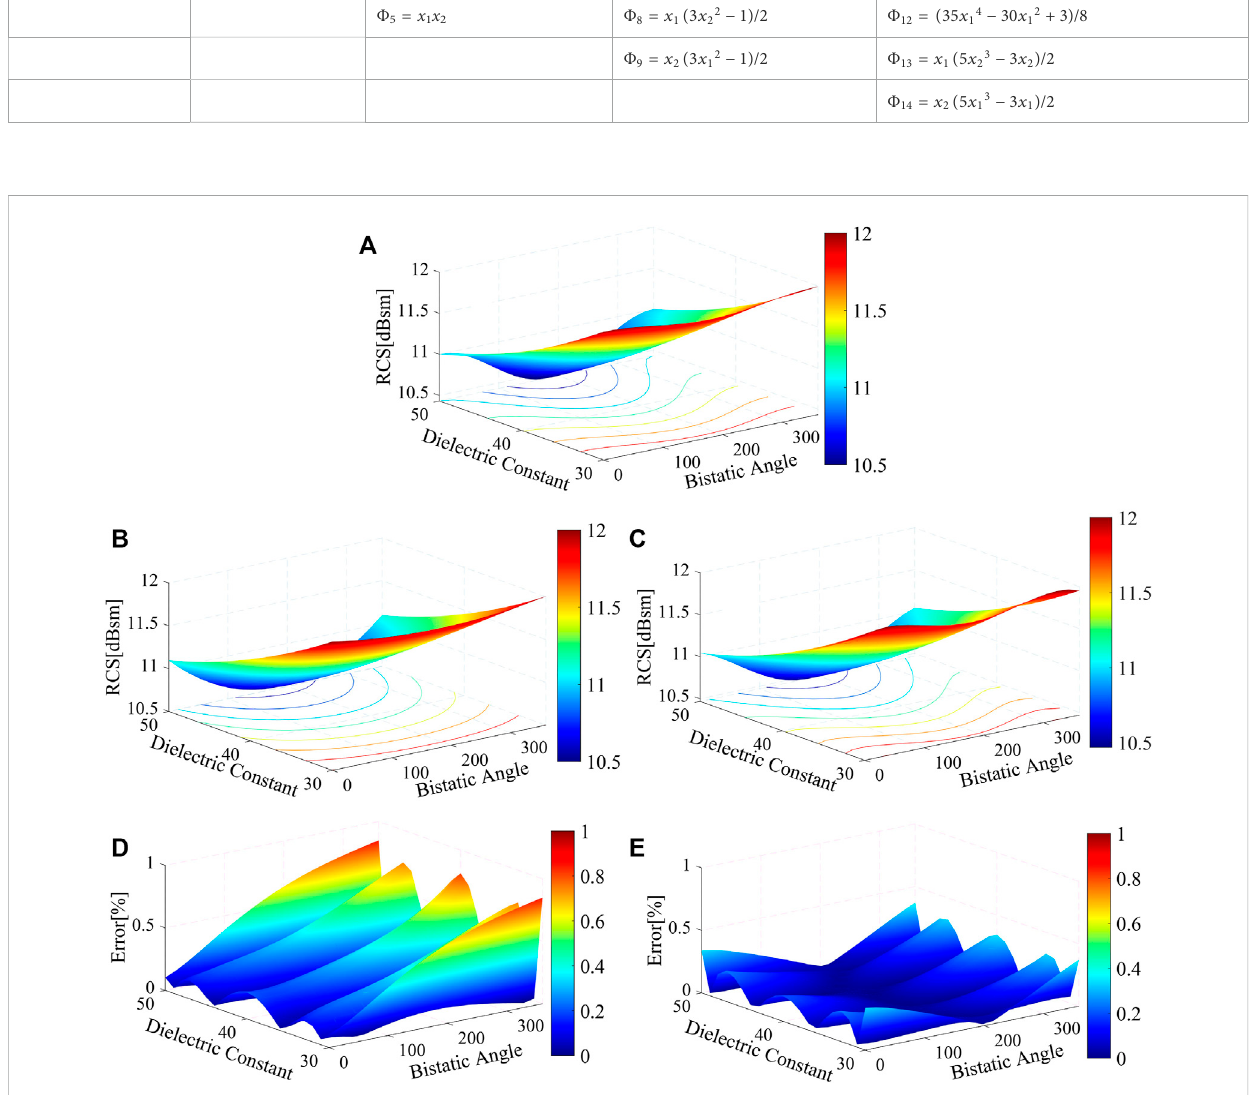
FIGURE 9 Surface results of the bivariate analysis with dielectric constant and bistatic angle: (A) analytical solution, (B) 3rd PCE result, (C) 4th PCE result, (D) relative error of the 3rd PCE model, and (E) relative error of the 4th PCE model.